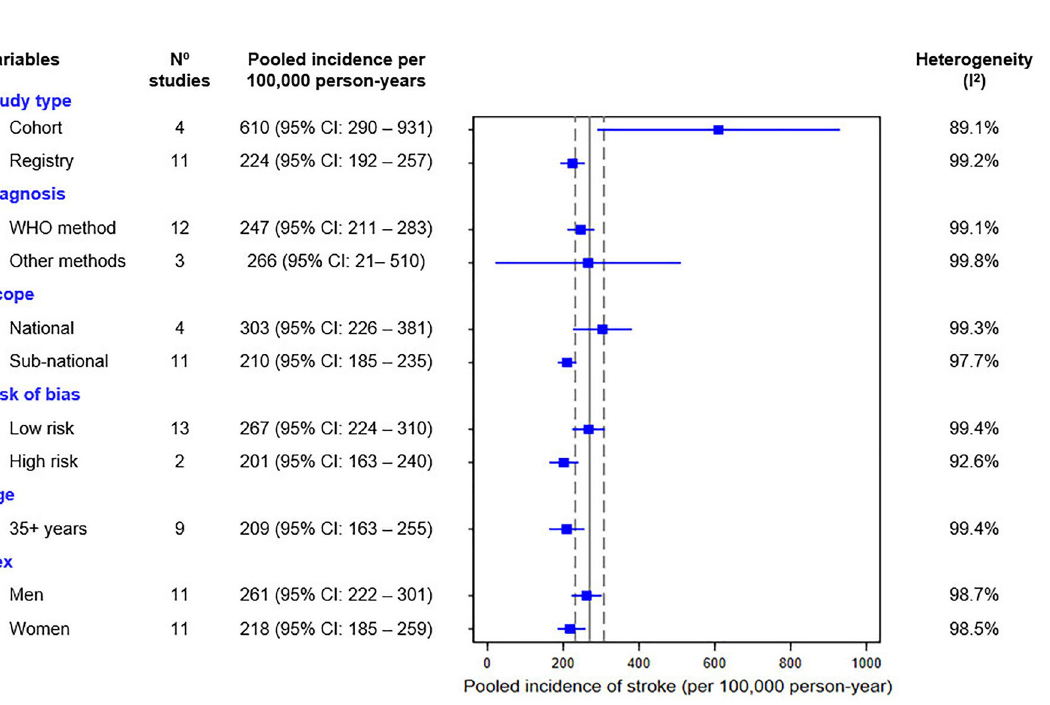
Figure 5. Forest plot of incidence rate about stroke in subgroup analysis according to different variables of interest. Meta-analysis was calculated by fitting a logistic-normal random-effect model without covariates and heterogeneity was assessed with the statistical test I2. Vertical continuous line represents the overall estimate of the incidence of stroke in the general population and dashed lines represent the 95% confidence interval (CI). Detailed forest plot of the general population incidence rate in Supplementary Figure